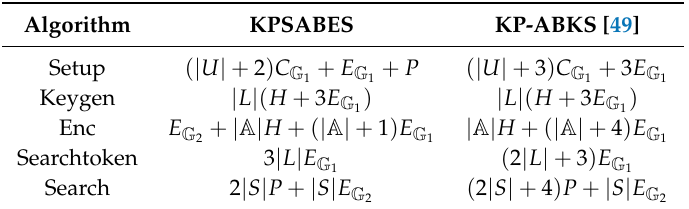
Table 2. The computation cost of algorithms in KPSABES and KP-ABKS [49].